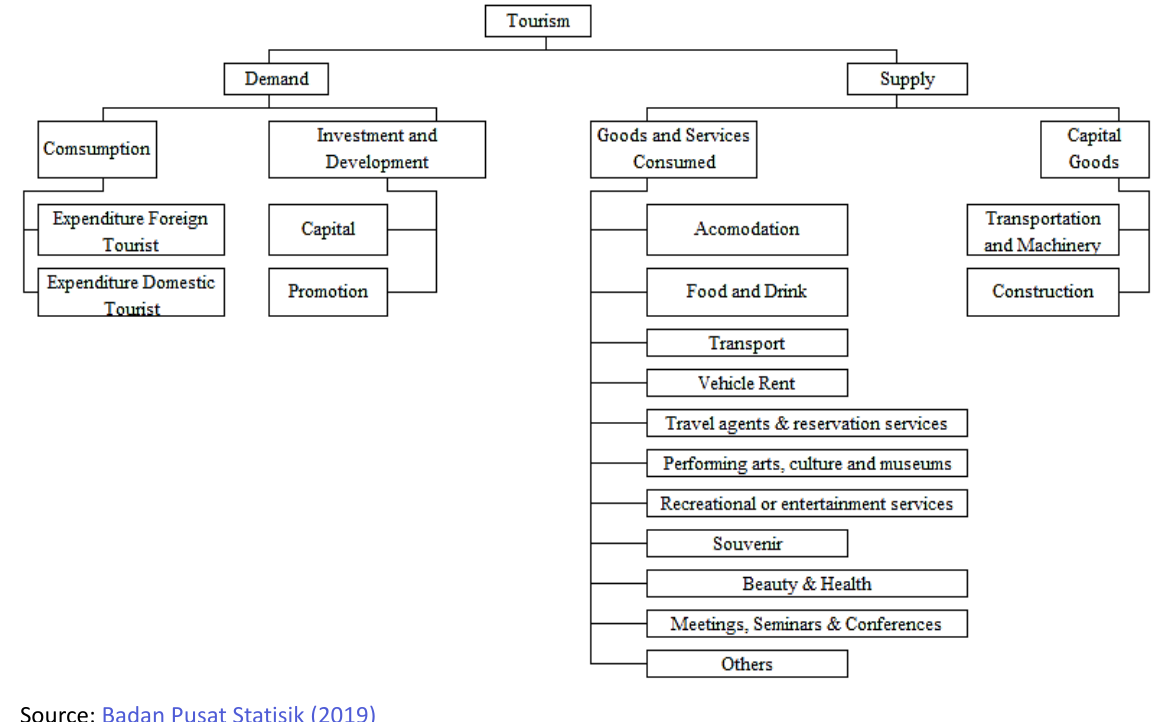
Figure 1: Tourism Demand and